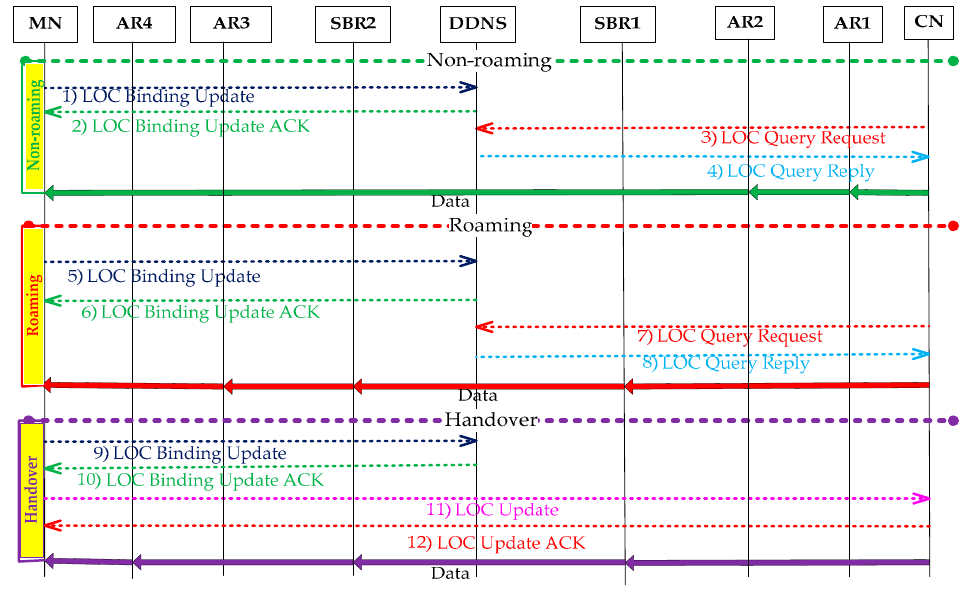
Figure 2. Identifier-locator (ID-LOC) management of ILNP-Global scheme.